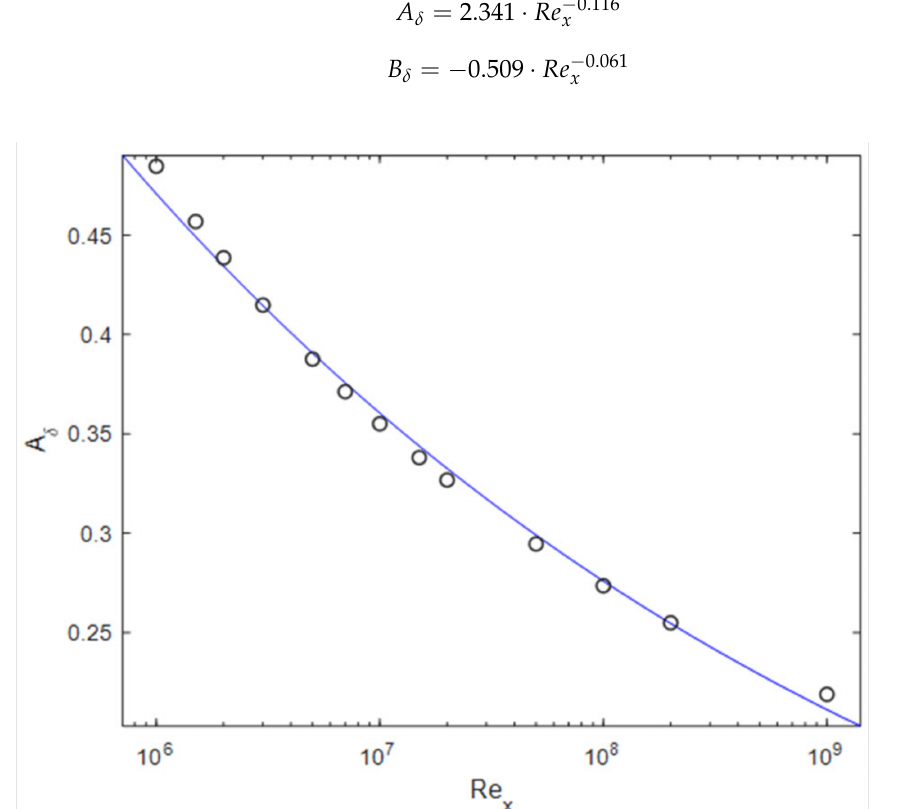
Figure 2. A δ over Re x according to Equations (7), (8), and (26) (circles) and logarithmic fit (blue